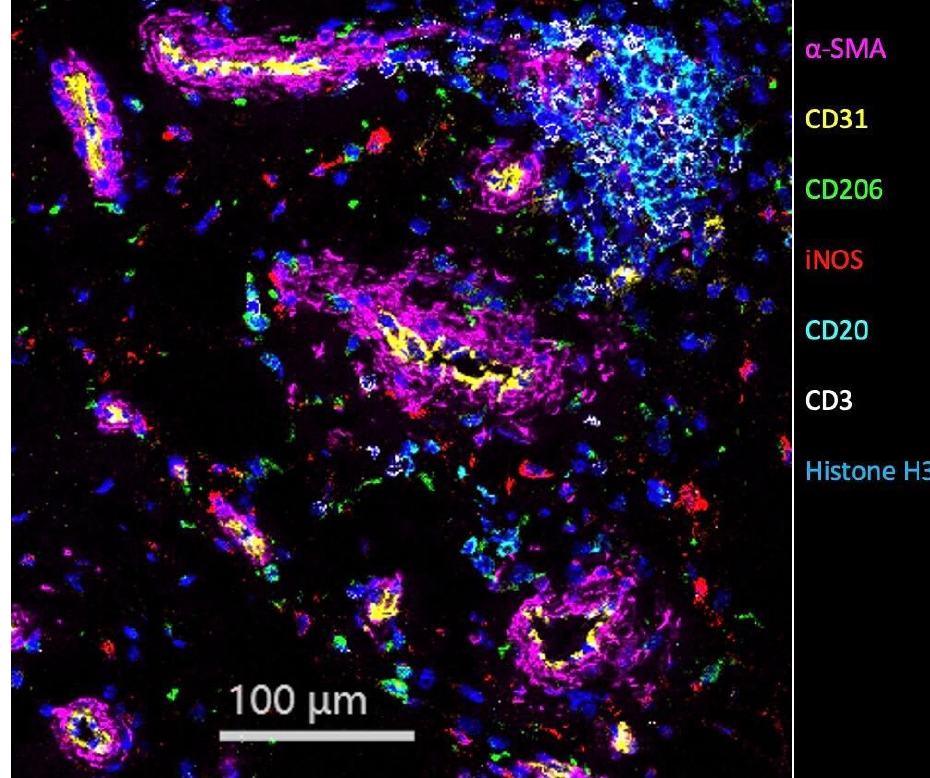
Figure 3. IMC imaging on human synovial membrane sample. Seven markers from a 30 ‐ marker panel were shown in the image. Magenta: α‐ Smooth muscle actin ( α‐ SMA); Yellow: CD31; Lime: CD206; Red: iNOS; Cyan: CD20; White: CD3; Blue: Histone H3.